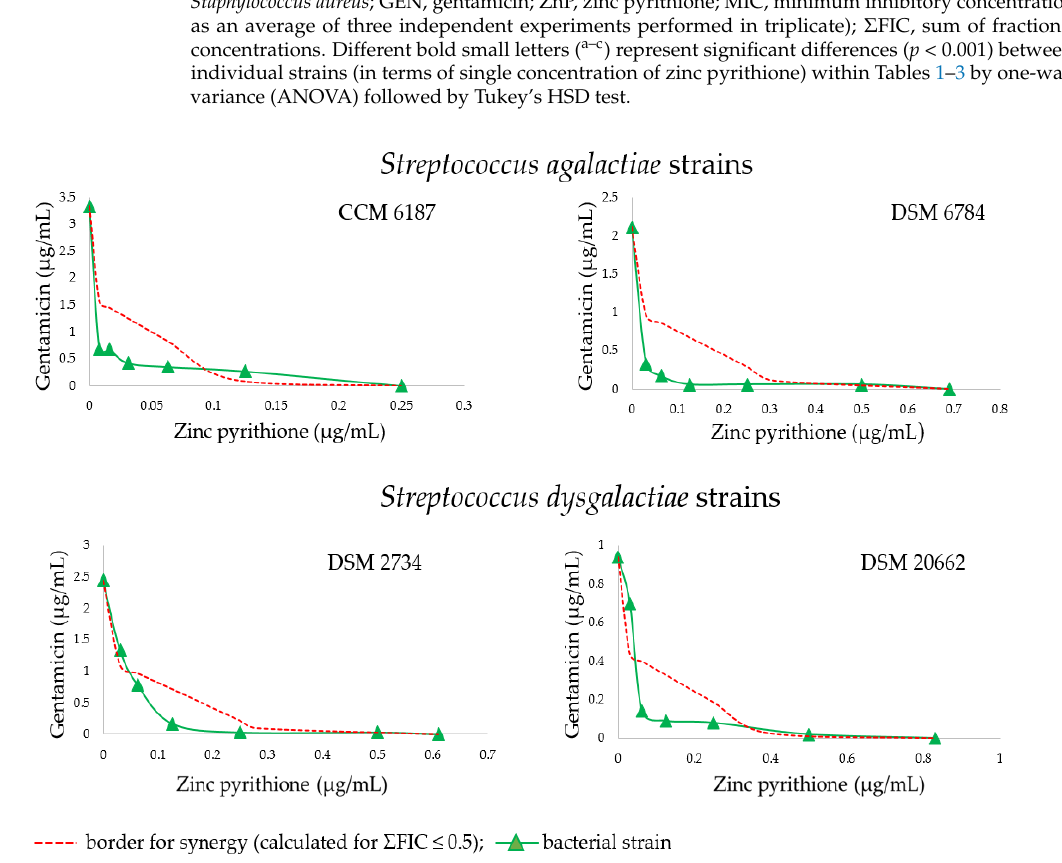
Figure 2. Isobologram of the interactions between gentamicin and zinc pyrithione binary combina- tions against Staphylococcus aureus strains. Synergy (ΣFIC ≤ 0.5).